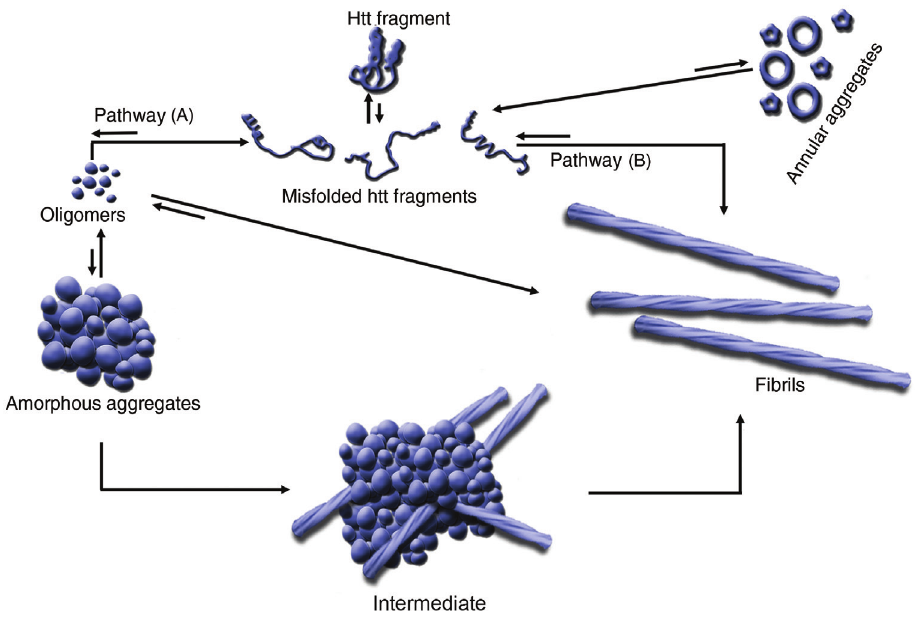
Figure 2: A schematic model for huntingtin (htt)